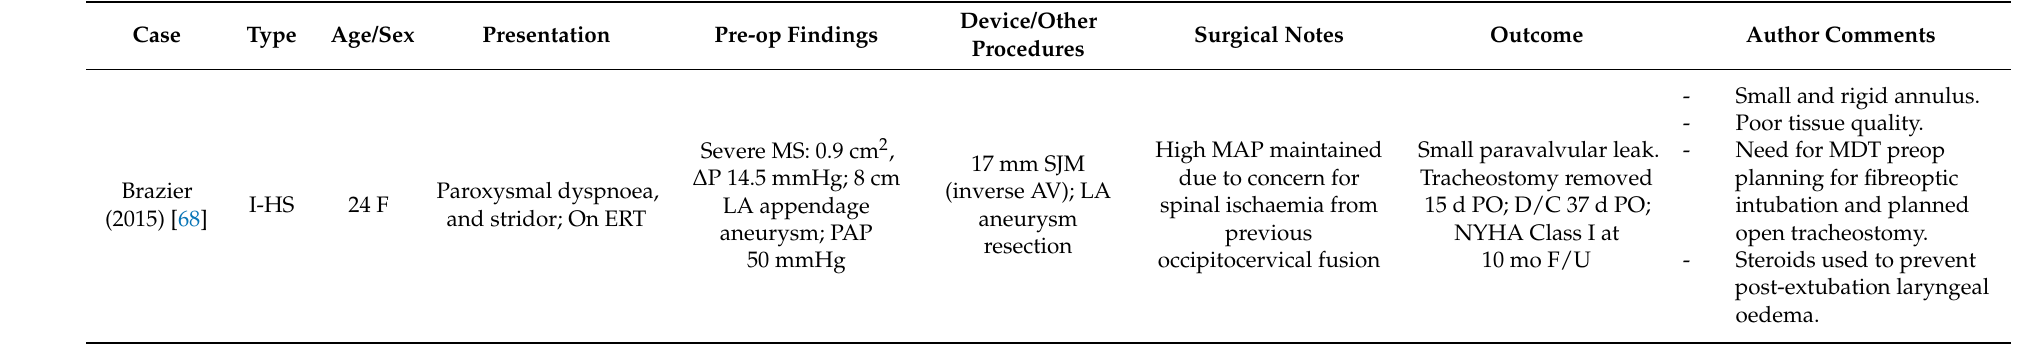
Table A3. Description of case reports of mitral valve replacement in MPS